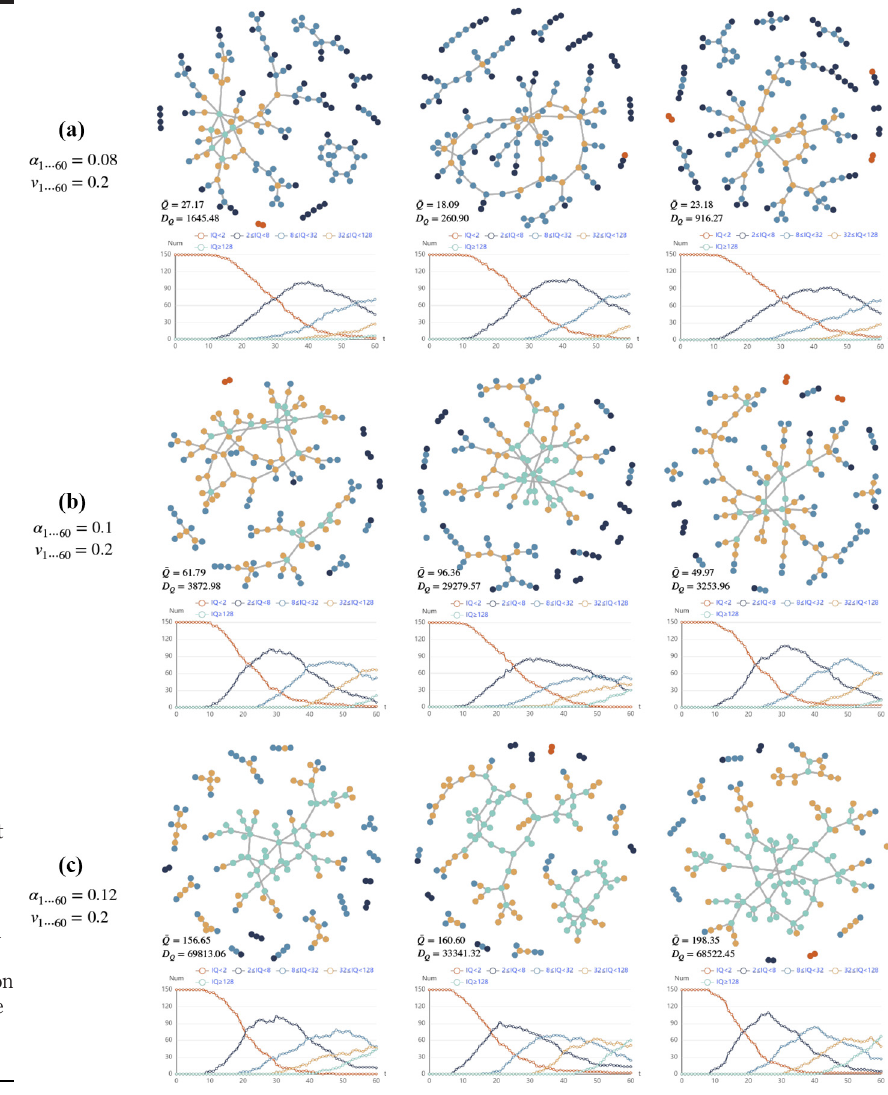
Figure 3. In fl uence of different interaction rates on crowd intelligence evolution. In our proposed interaction method, even small changes in interaction rate can still produce qualitative changes after 60